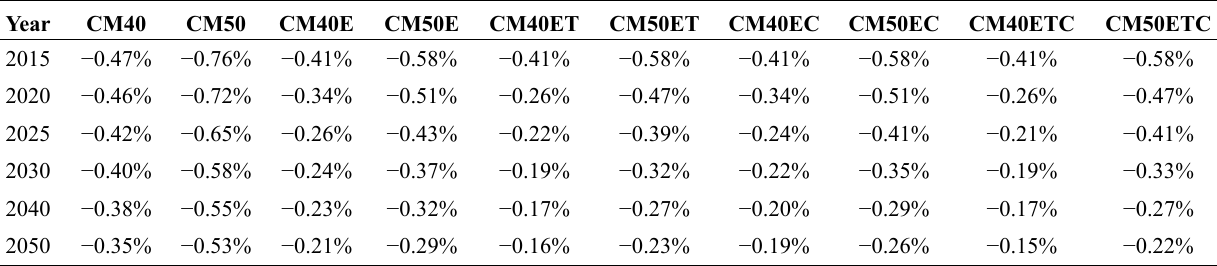
Table A6. Change of oill supply in 2050.